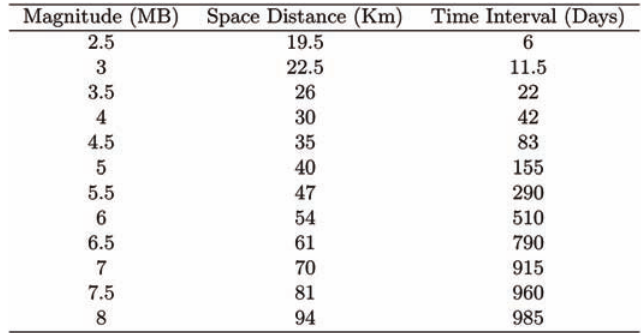
Table 1. A reference for distinguishing foreshocks and aftershocks from main-shocks [from Sadeghian and Jalali-Naini